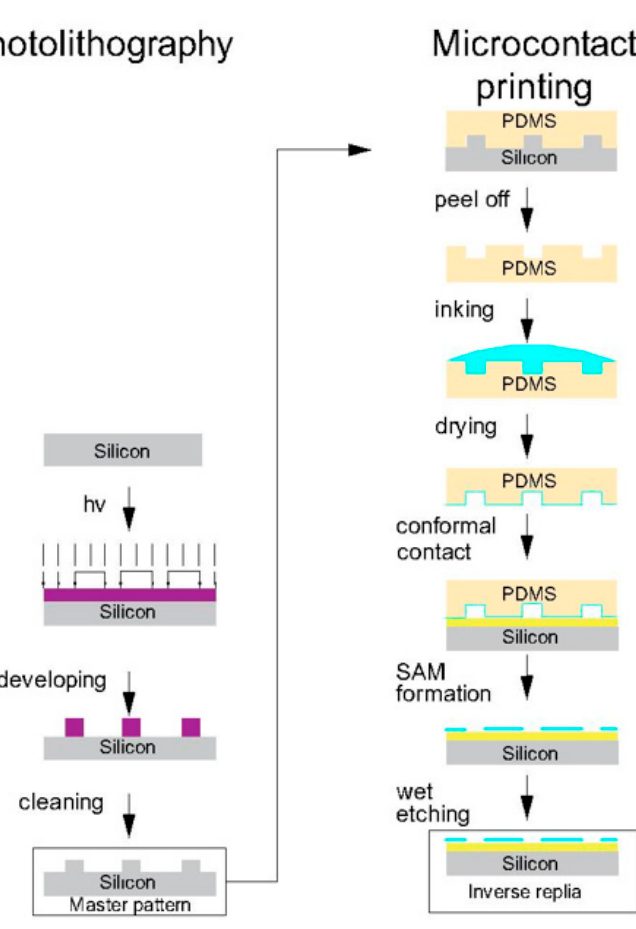
Figure 9. Flow chart of micro-contact printing.